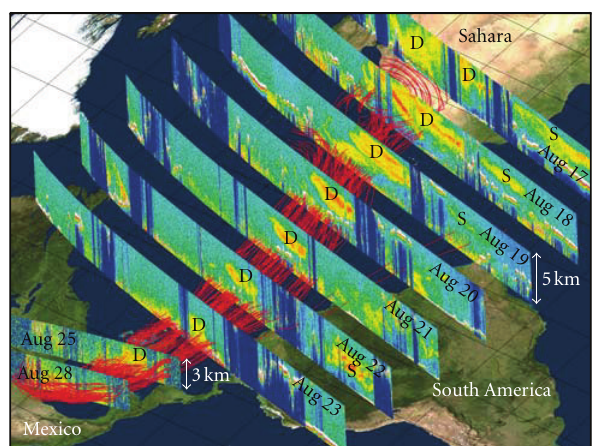
Figure 6: A figure reported in [80] shows an example demonstrat- ing the capability of CALIOP to track dust long-range transport. A dust event that originated in the Sahara desert on 17 August 2007 and was transported to the Gulf of Mexico. Red lines represent back trajectories indicating the transport track of the dust event. Vertical images are 532 nm attenuated backscatter coe ffi cients measured by CALIOP when passing over the dust transport track. The letter “D” designates the dust layer and “S” represents smoke layers from biomass burning in Africa (17–19 August) and South America (22